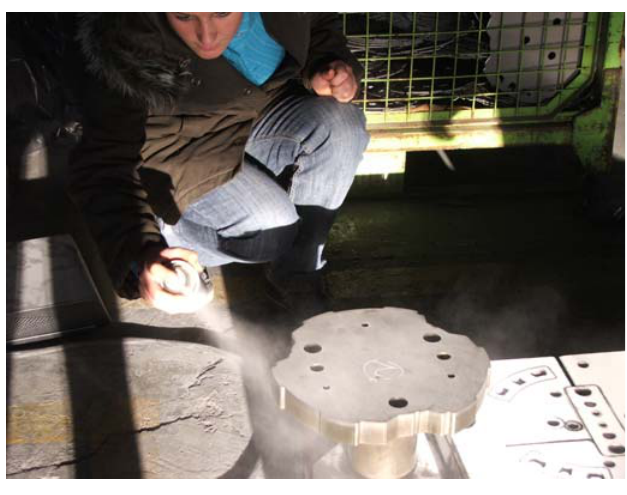
Figure 4. Preparation of the scanned